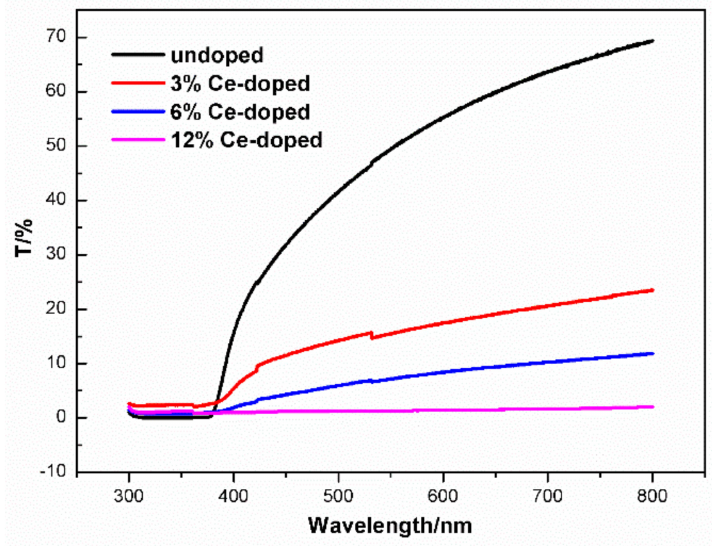
Figure 4. UV-vis optical transmittance of un-and Ce-doped ZnO